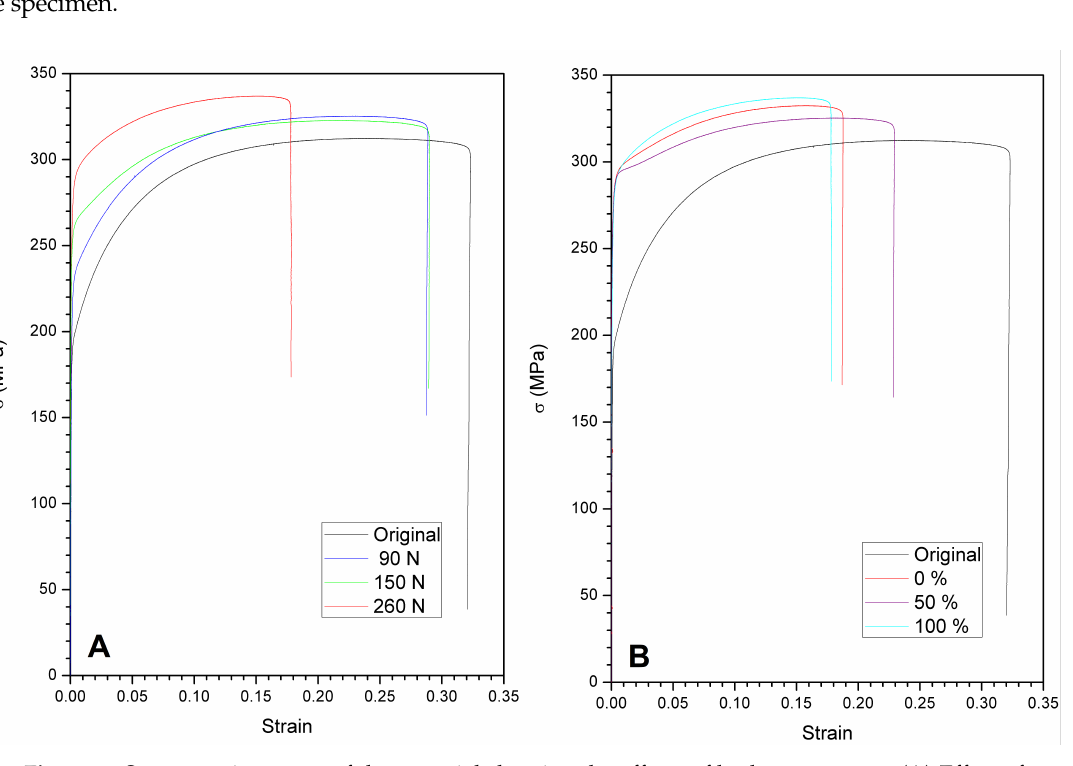
Figure 7. Stress–strain curves of the material showing the effects of both parameters. ( A ) Effect of preload with a 100% amplitude. ( B ) Effect of amplitude with a 260 N